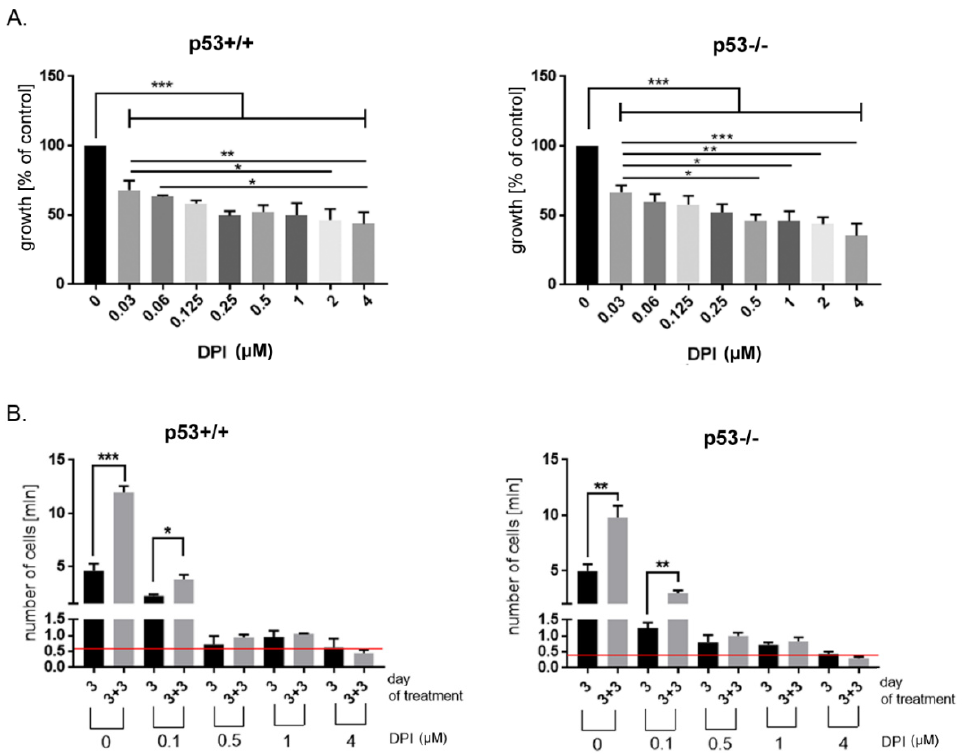
Figure 1. Diphenyleneiodonium chloride (DPI) exerts growth inhibitory effect in HCT116 p53+/+ and p53 − / − cancer cells. ( A ) The influence of different concentrations of DPI on HCT116 cell viability after 24 h of treatment (MTT assay); ( B ) Inhibition of cell proliferation upon DPI treatment. HCT116 cells were treated with different concentrations of DPI and cells were counted after 3 days of treatment and after subsequent 3 days of culture in DPI-free medium (day 3 + 3). Red lines mark the initial number of cells, * p < 0.05, ** p ≤ 0.01; *** p ≤ 0.001.